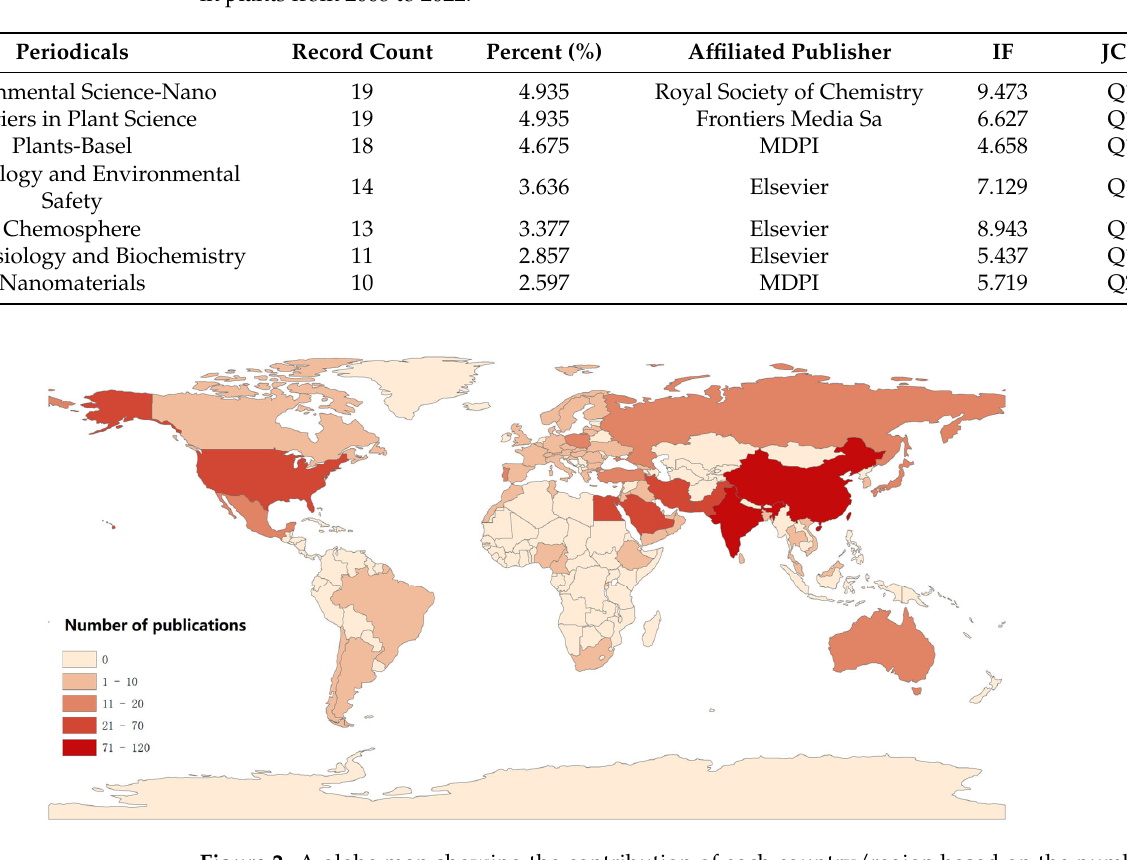
Table 2. The top seven periodicals that published papers regarding NPs enhancing abiotic tolerance in plants from 2008 to 2022.